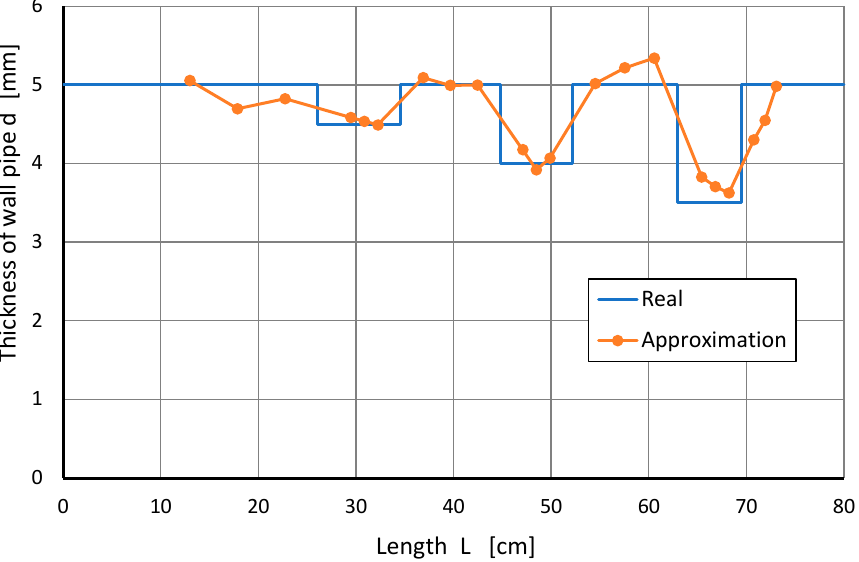
Figure 13. Fitting the measurement points for the applied second-order regression for experiment VIII. Approximation errors (related to the actual pipe wall thickness) were calculated for a better visual assessment. The results of the exemplary series VII of measurements are shown graphically in Figure 14. It is noteworthy that for places of reduced thickness, the approximation errors usually have negative values. The diagram also shows the change in pipe wall thickness.